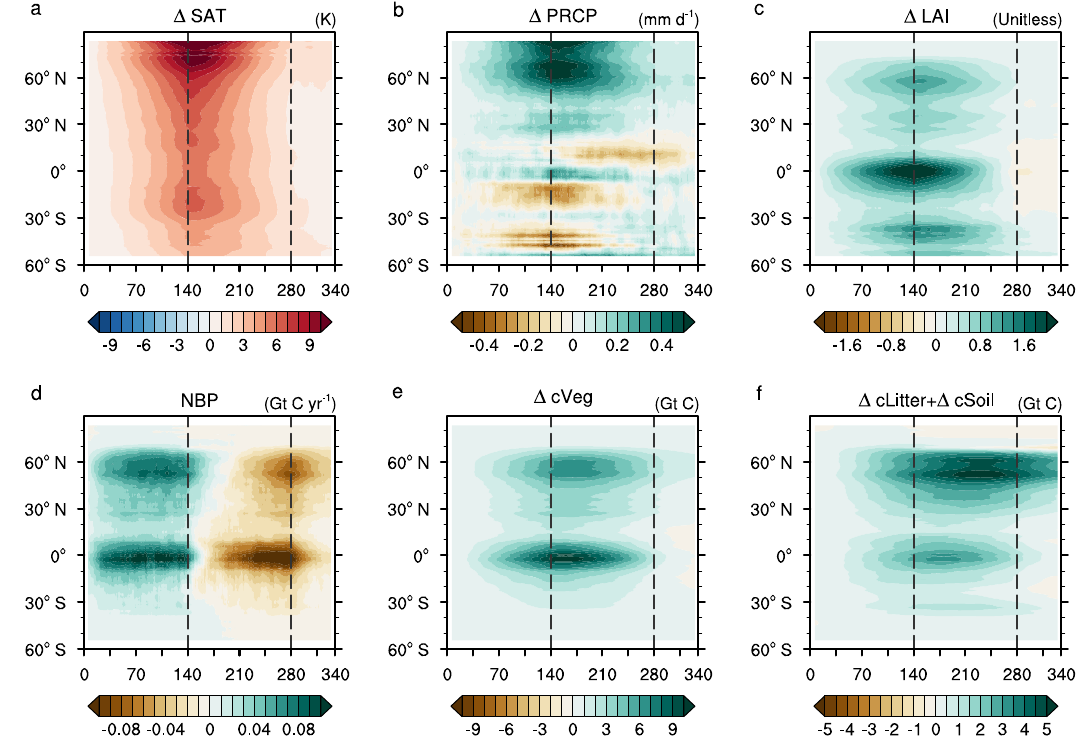
Fig. 2 Latitudinal differences in the response of the climate system and terrestrial carbon cycle to CO 2 forcing. a – f Time-latitude diagrams of annual mean anomalies of changes in land SAT ( a ), land PRCP ( b ), and leaf area index (LAI) ( c ). The zonal sum of annual NBP ( d ), vegetation carbon (cVeg) anomaly ( e ) and sum of cLitter and cSoil anomalies ( f ). All values are MME and smoothed by the 11-year moving average. The beginning and end of CO 2 changes are indicated by the gray dashed vertical